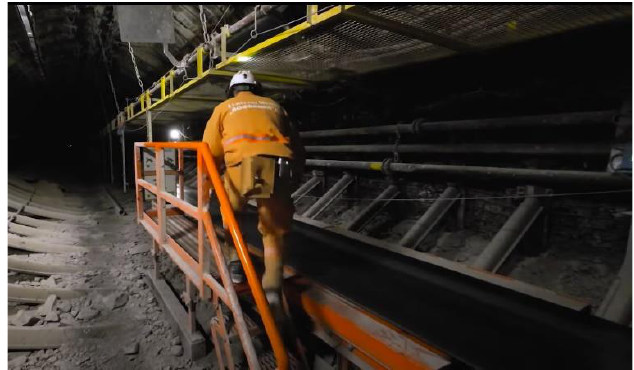
Figure 7. Underground transport means used in LW Bogdanka S.A. — Belt conveyor for transporting people. Source: photo provided by LWB.